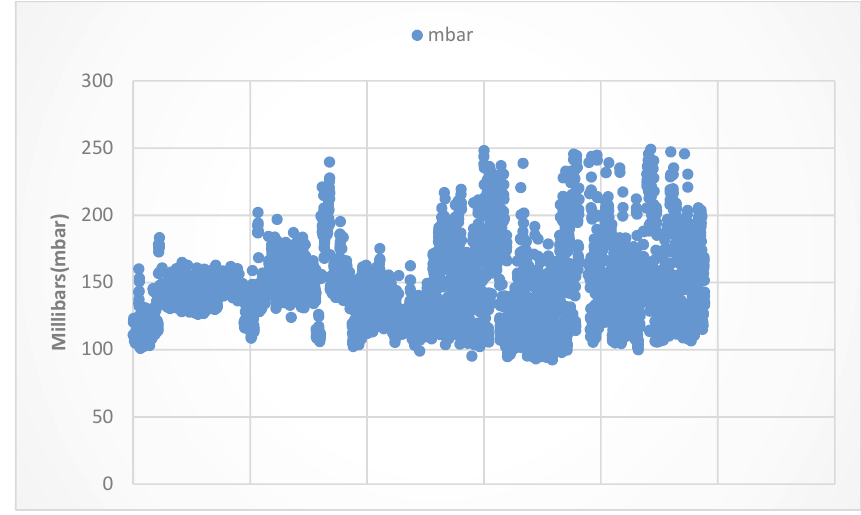
Fig. 4. vacuum pressure distribution